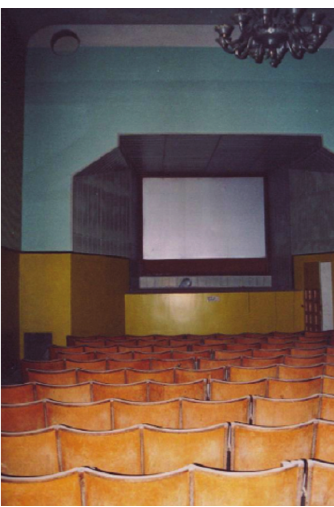
Figure 7: The room “Italy” on the first floor of the theatre.